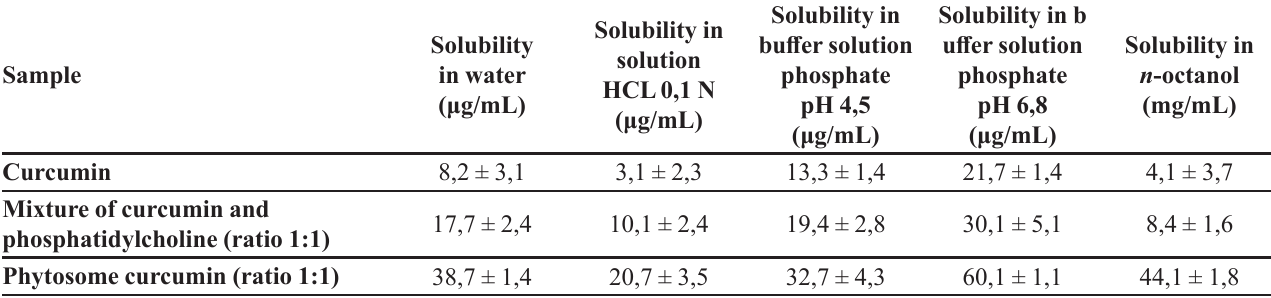
TABLE III - Solubility of curcumin, phytosome and mixture of curcumin and phosphatidylcholine in different medium